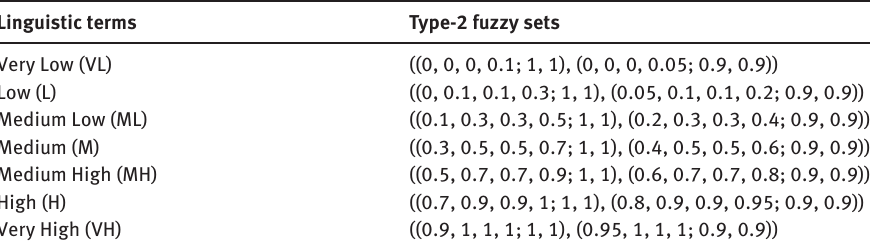
Table 1. Linguistic Terms and Corresponding Type-2 Fuzzy Sets [18]. Linguistic terms Type-2 fuzzy